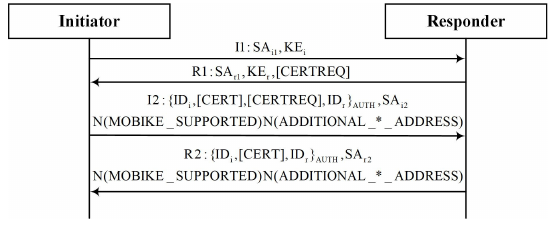
Figure 1. IKEv2’s initial exchanges.